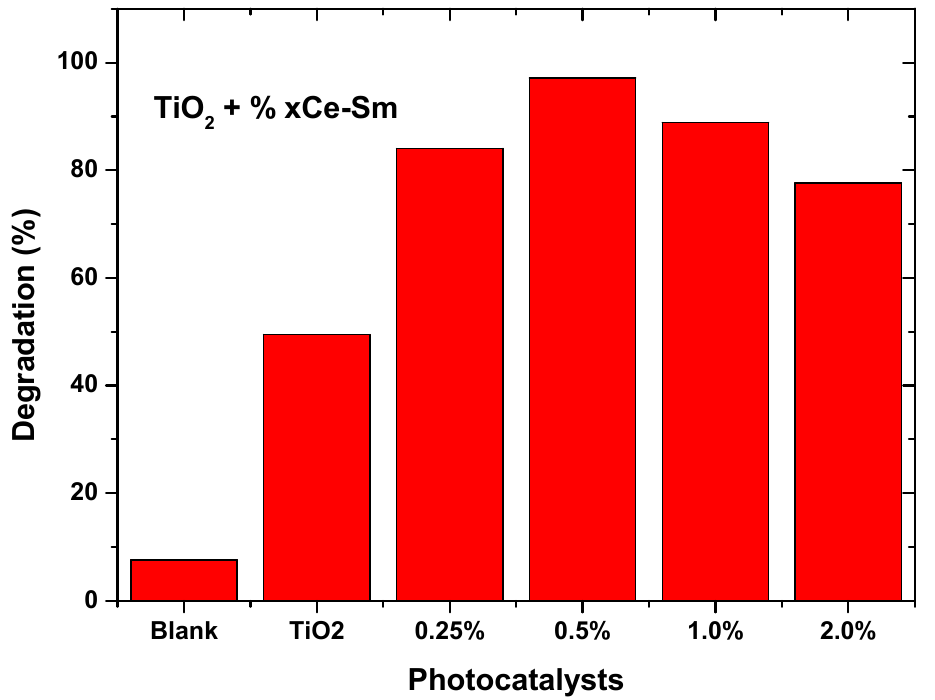
Figure 10. Degradation of RB dye of Ce–Sm co-doped TiO 2 NPs ( x = 0.00, 0.25, 0.50, 1.00, and 2.00%).